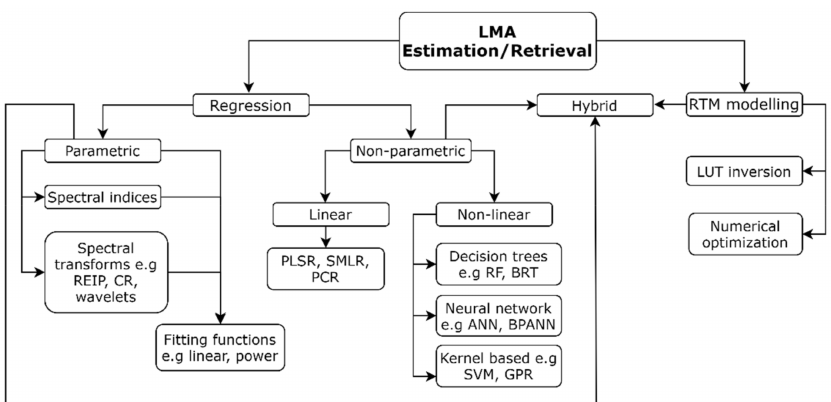
Figure 5. An overview of methods and techniques used in leaf trait retrieval/estimation. Modified based on [29] REIP: red edge inflection position, CR: continuum removal, PLSR: partial least squares regression, SMLR: stepwise multiple linear regression, PCR: principal component regression, RF: random forest, BRT: boosted regression trees, ANN: artificial neural network, BPANN: back propaga- tion artificial neural network, SVM: support vector model, GPR: Gaussian process regression, LUT: lookup table, RTM: radiative transfer